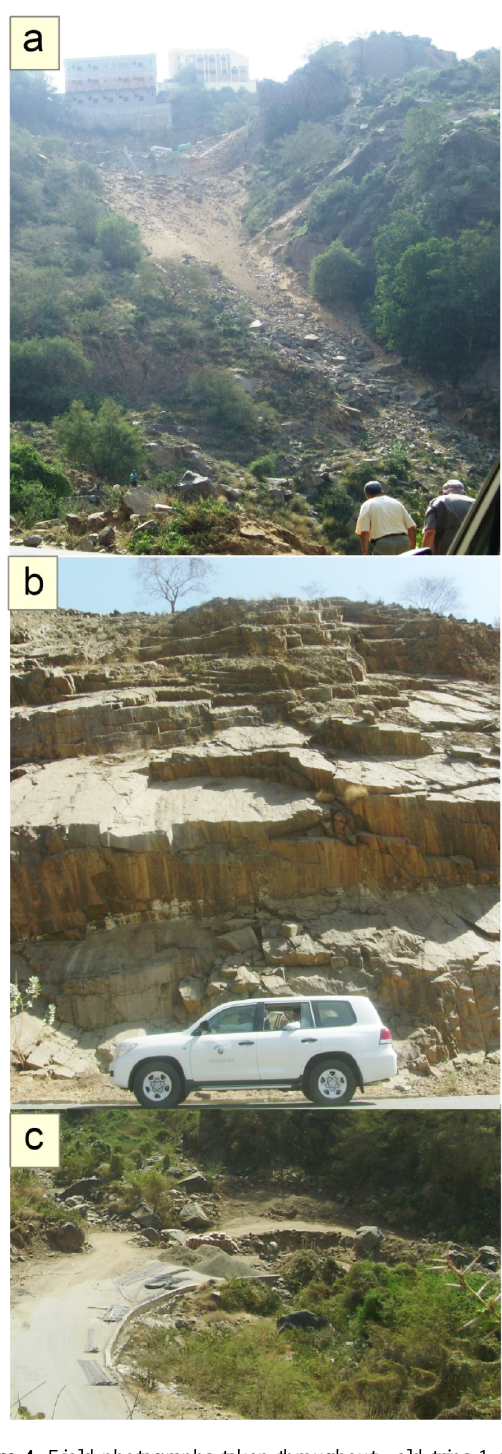
Figure 4. Field photographs taken throughout field trips 1 and 2: (a) landslide caused by debris flows within an ephemeral valley; (b) area prone to landslide development by failure along fracture planes that dip towards the road; and (c) intersection of debris flow with